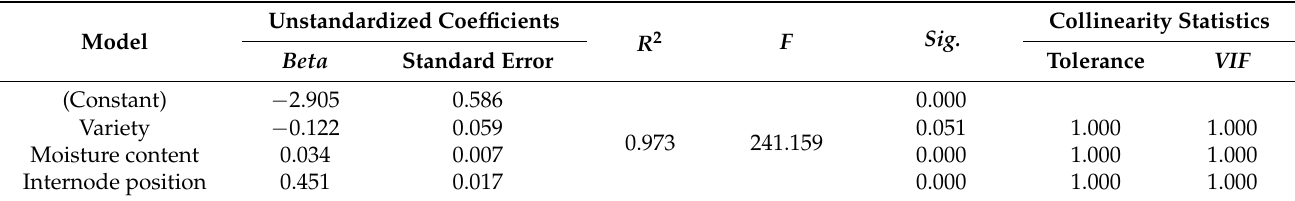
Table 2. Table of regression coefficients of the thickness of bunch stalk rind.